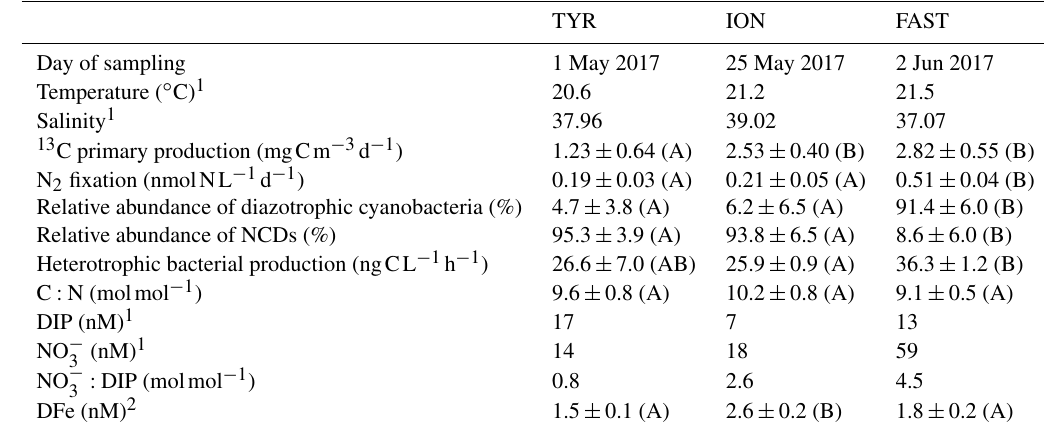
Table 2. Initial physico-chemical and biological properties of surface seawater before the perturbation in the dust seeding experiments at TYR, ION and FAST (average at T0 in C and D treatments ( n = 4) or value at T − 12h ( n = 1) in the pumped surface waters). The relative abundances of diazotrophic cyanobacteria and NCDs (non-cyanobacterial diazotrophs) are given as proportion of total nifH sequence reads. DIP: dissolved inorganic phosphorus; DFe: dissolved iron. The C : N ratio corresponds to the ratio in the organic particulate matter from IRMS (isotopic ratio mass spectrometer) measurements ( > 0.7µm). Means that did not differ significantly between the experiments ( p > 0.05) are labeled with the same letter (in